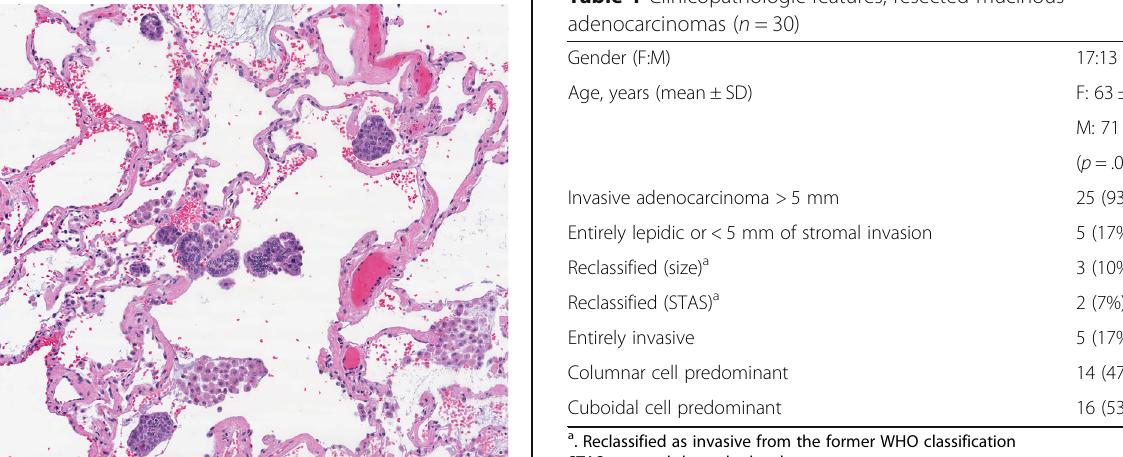
Table 1 Clinicopathologic features, resected mucinous